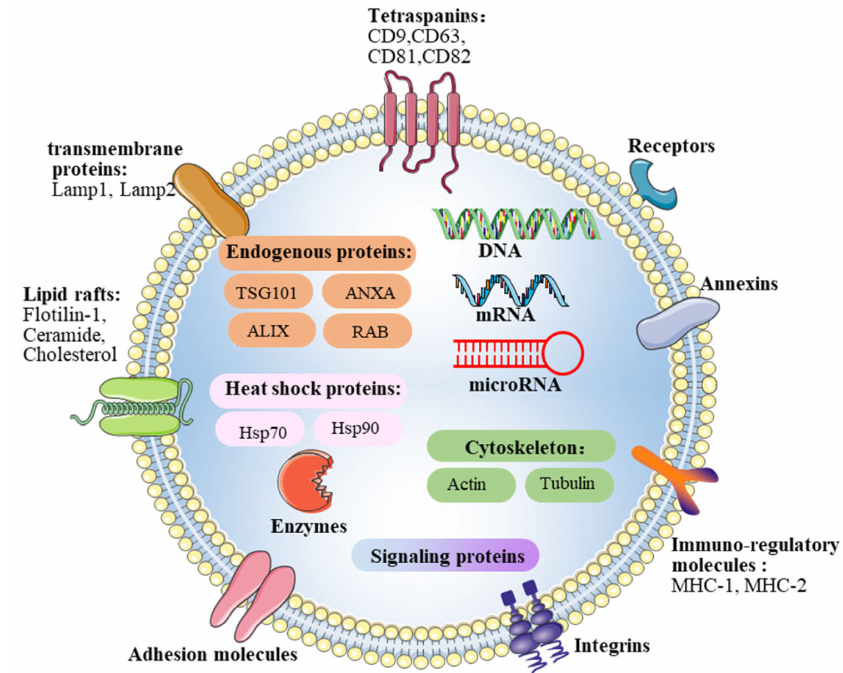
Figure 2. Contents of exosomes. As lipid bilayer membrane vesicles, exosomes are rich in choles- terol, phospholipids, and ceramides. Exosomes contain conserved proteins, such as tetraspanins, integrins, immune-regulatory molecules, protein membrane transport fusion proteins, as well as transmembrane proteins (Lamp1, Lamp2). In addition, exosomes contain many biologically active molecules, including enzymes, DNA, mRNA, and microRNA,